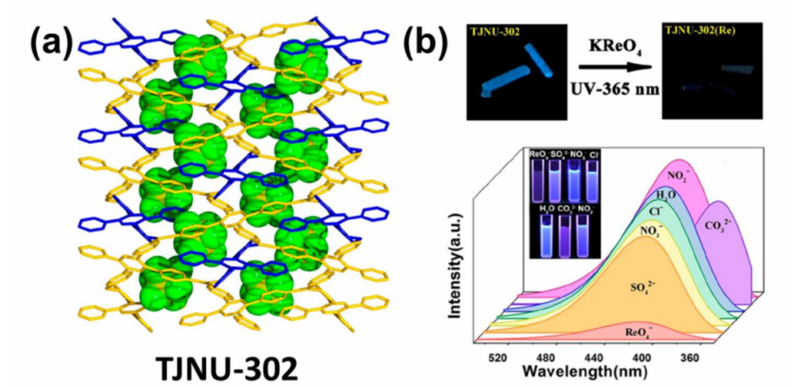
Figure 14. ( a ) Structure of TJNU-302. ( b ) UV photos of TJNU-302 crystals before and after immersion in KReO 4 water solution and emission spectra of TJNU-302 in water solutions containing different anions. Adapted from